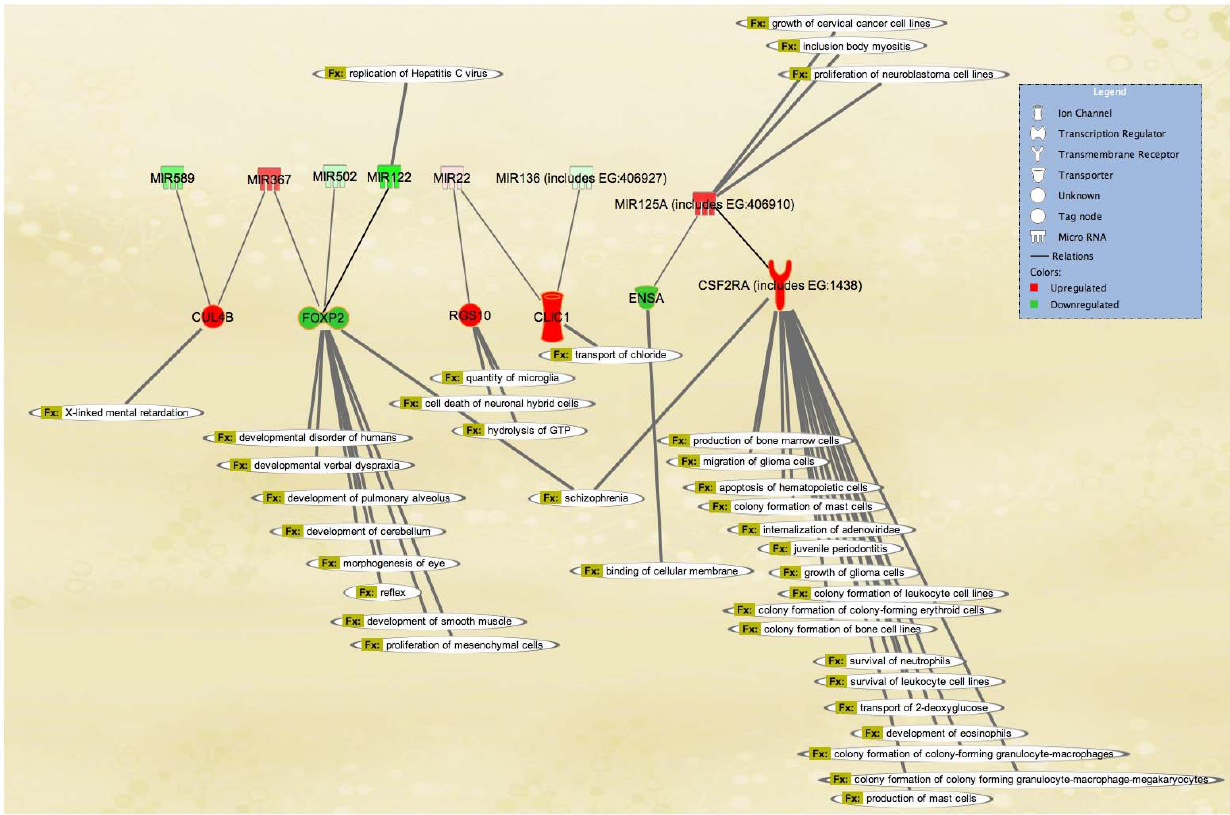
Figure 9. Pathway analysis of mRNAs and miRNAs. MiRNAs were chosen on the basis of their highly significant target bias, and mRNAs chosen that had a high number target sequence sites in 3 9 UTRs. Ingenuity Pathway Analysis algorithm, database, and software was used to illustrate the interrelationships and functional relationships.